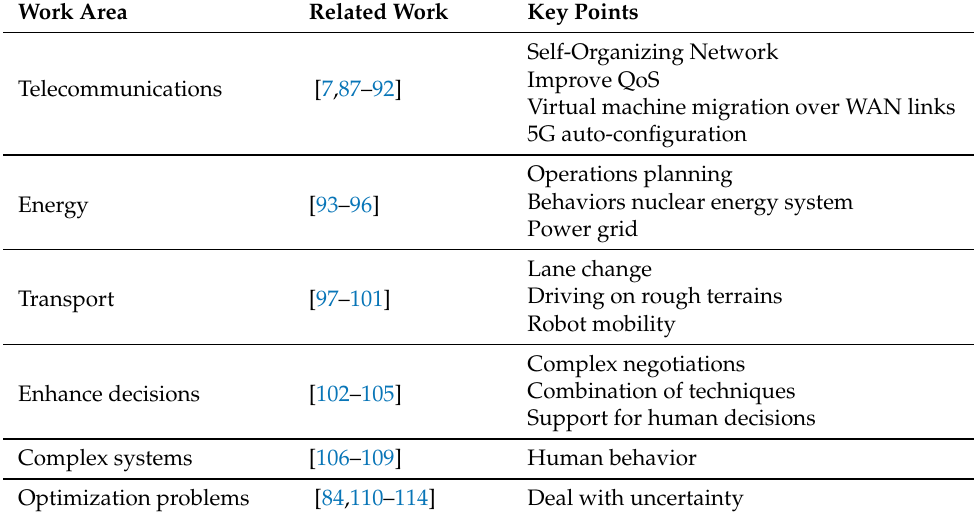
Table 4. Works that apply supervised